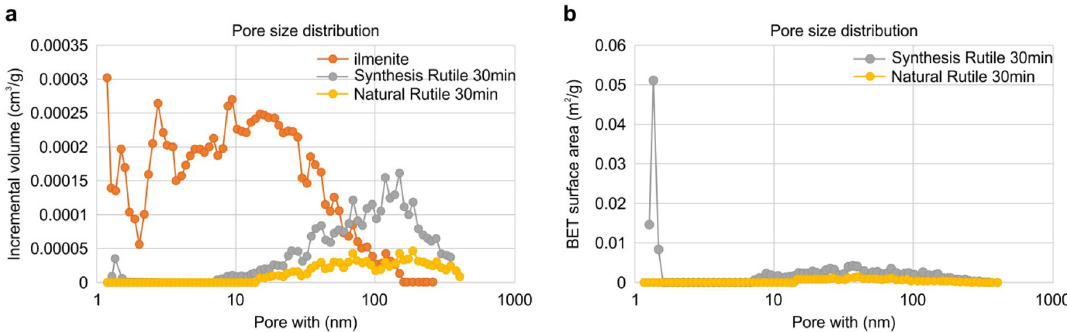
Figure 6. Analysis results of ( a ) incremental volume of ilmenite and synthetic/natural rutiles chlorinated for 30 min ( b ) BET surface area of synthetic/natural rutiles chlorinated for 30